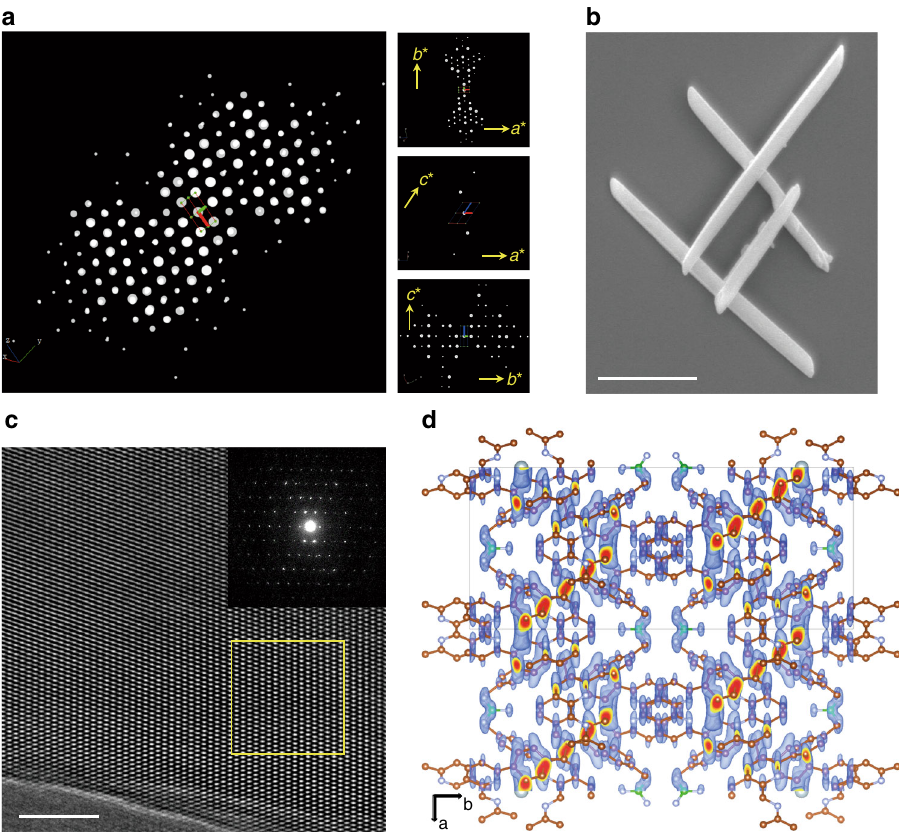
Fig. 2 Structure characterisation and analysis of mCOF-Ag. a 3D reciprocal lattice of mCOF-Ag reconstructed from the SCED data (left) and 2D slices cut from the reconstructed reciprocal lattice (right). b SEM image of mCOF-Ag with uniform rod-like morphology. Scale bar: 1 µ m. c HRTEM image of mCOF- Ag and SAED pattern (inset) con fi rmed the single-crystal nature of the material. Scale bar: 20 nm. d Observed electron density map of the initial structure model determined from SCED data along the c